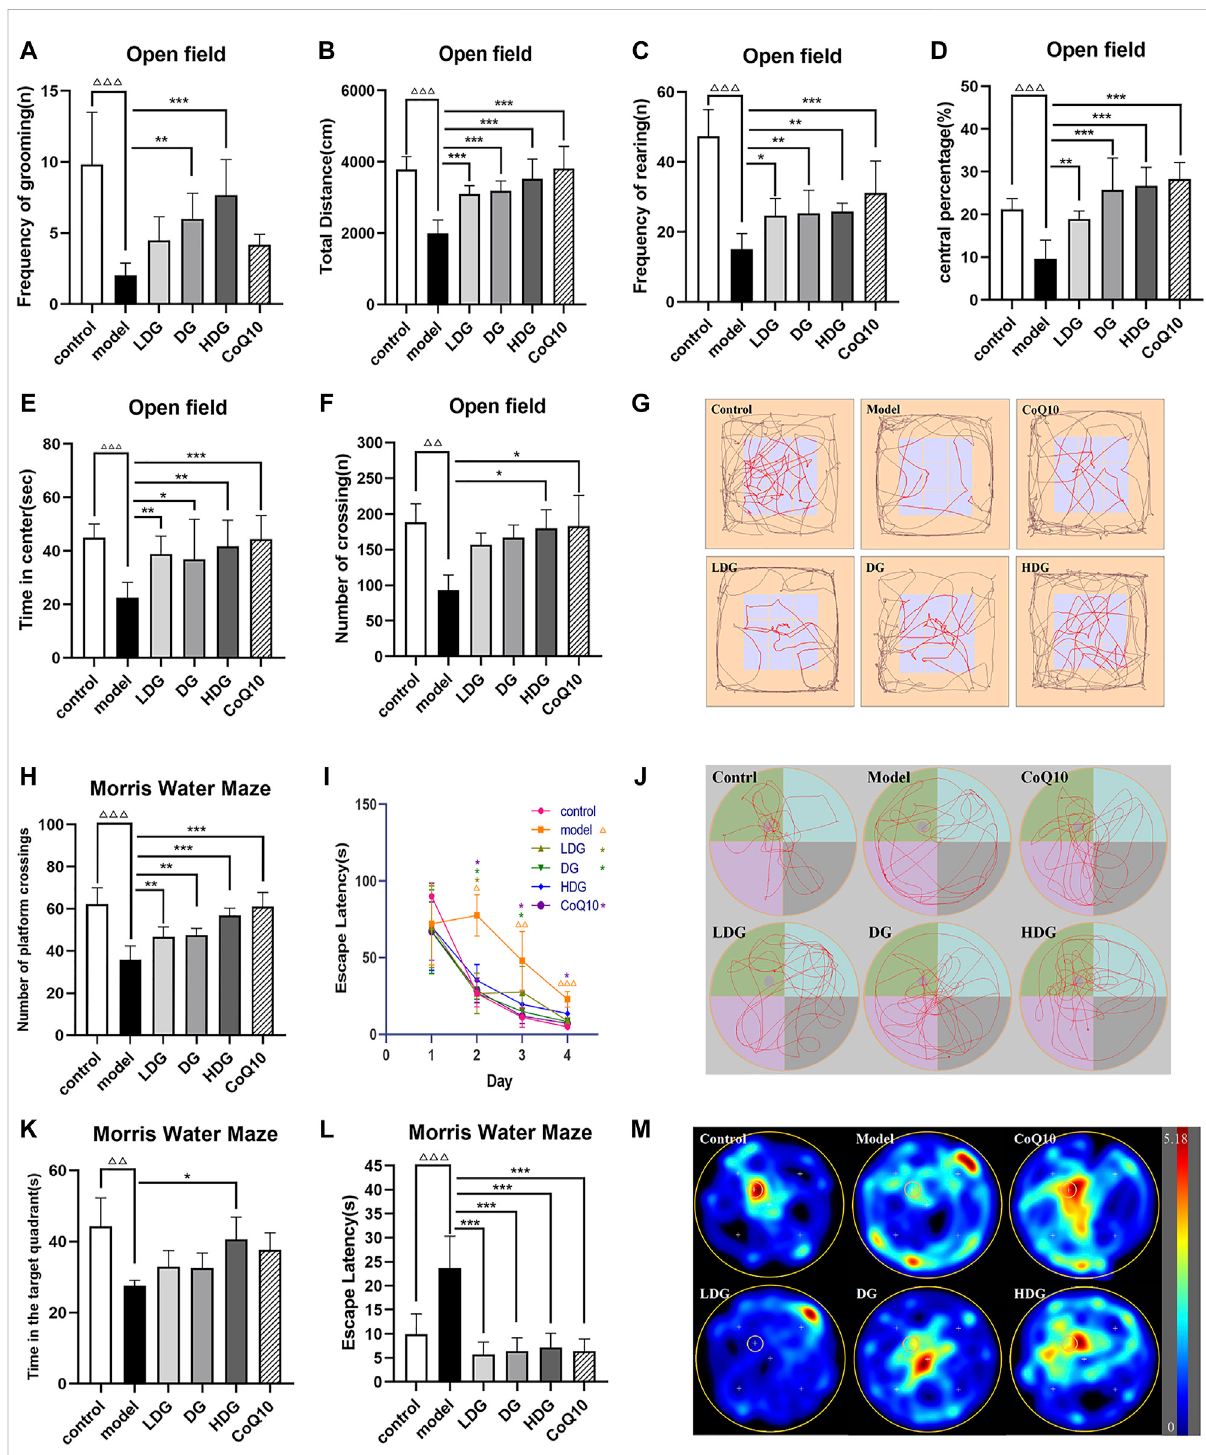
FIGURE 3 Effects of KPLD on emotion, spontaneous activity, and cognitive function of learning and memory evaluated by OFT and MWM tests. The total movingdistance,timeinthecenter,centralpercentage,numberofcrossing,frequencyofrearingandgroomingofratsonOFT (A – F) ,andthemapof representativemovement trajectories ineachgroup for 5 min intheopen fi eld (G) areshown. The numbers ofplatformcrossings (H) andthetime in target quadrant (J) on the last day during MWM test. The escape latencies in the fi rst four consecutive days of positioning navigation training (I) and in the last day of spatial probe testing of fi nding hidden platforms (K) are shown. Representative swim paths during the spatial probe test (L) and heat map according to frequency and position of swimming paths (M) . Data were expressed as (mean ± SD), ΔΔ p < 0.01, ΔΔΔ p < 0.001 vs. control group; * p < 0.05, ** p < 0.01, *** p < 0.001 vs. CF model group ( n =